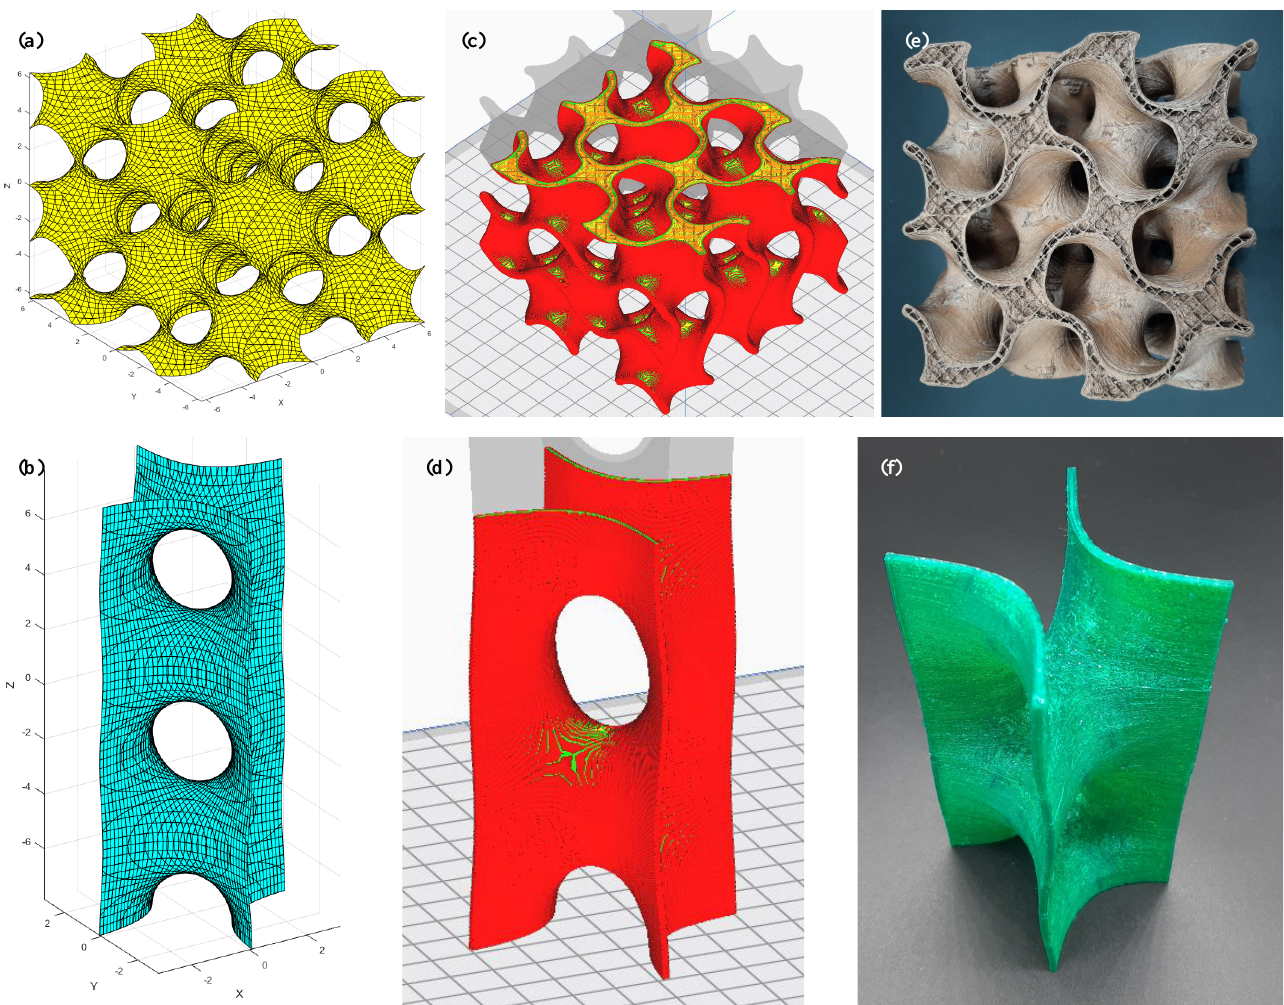
Figure 20. Case Study 3. ( a ) Mathematical model of the gyroid, ( b ) mathematical model of the Scherk surface, ( c ) g-code for final gyroid model, ( d ) g-code for final Scherk surface model, and ( e – f ) successfully manufactured